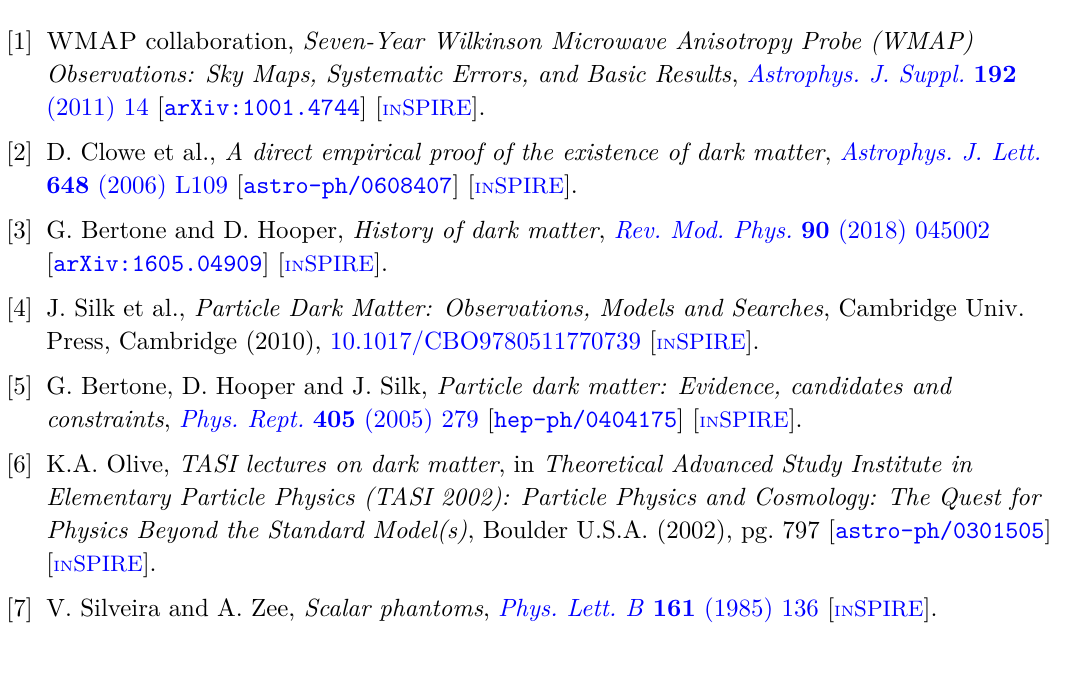
set s = 10 − 3 , which is the typical value for the mixing in order to get the correct relic α abundance near the resonances (see figure 6). We can see that DM masses larger than 10 GeV are excluded by the experimental constraint from